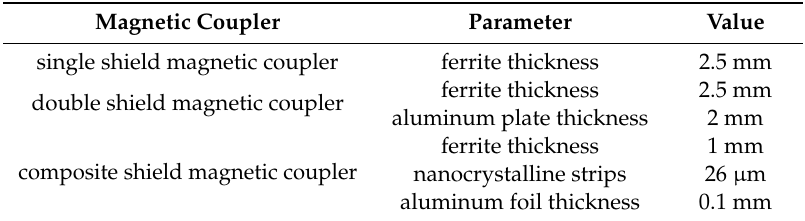
Table 3. Parameters of di ff erent types of shielding structure for receiving